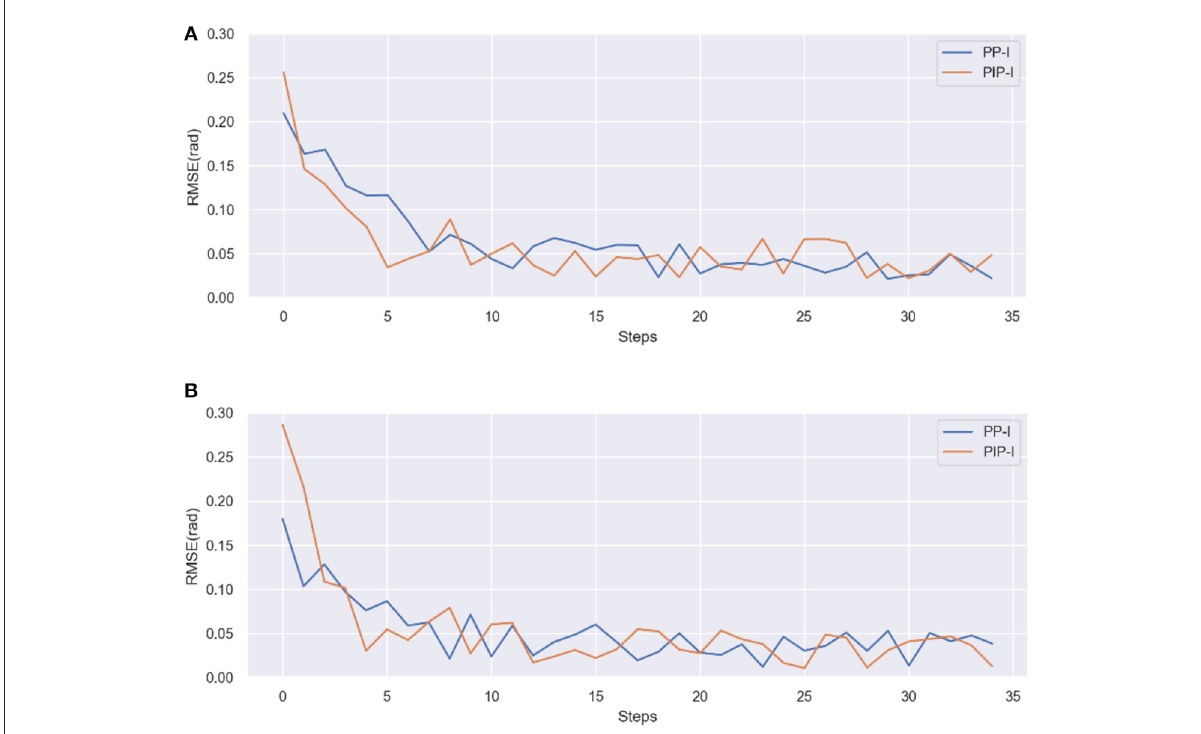
FIGURE11 The performances of PP-I and PIP-I in RMSE of error profiles. (A) Subject 5 # . (B) Subject 6 #